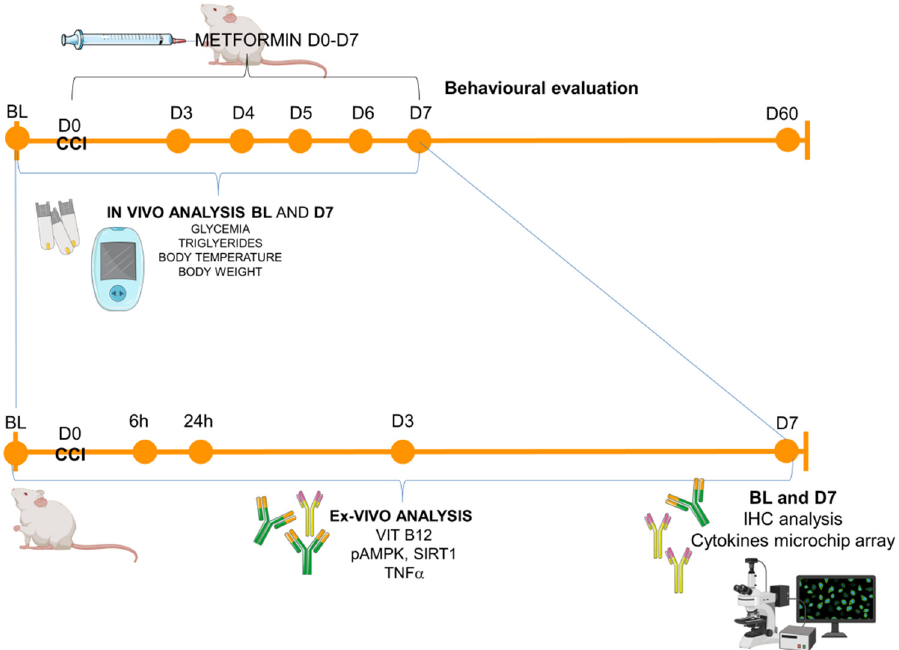
Figure 5. Experimental timeline. Schematic representation of the experimental schedule: animals (male and female CD1 mice) were tested in the baseline condition (BL) before the surgical induction of neuropathy (CCI–day 0, D0) and starting from day 3 (D3) post-ligature up to day 60 (D60). In-vivo metabolic measurements were performed in BL and D7, while for the ex-vivo analysis (from blood or sciatic nerves), the following time points were considered: BL (naïve mice), 6 h, 24 h, D3, D7 for ELISA immunoassay (Vit B12, pAMPK, SIRT1, TNFa) and BL and D7 for immunohistochemistry (IHC) and microchip array inflammatory panel.